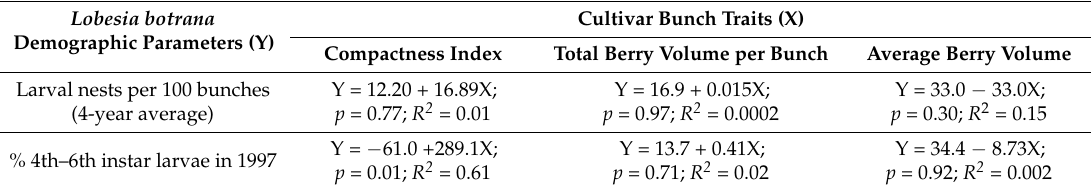
Table 3. Linear regression between cultivar bunch traits and Lobesia botrana demographic parameters. Lobesia botrana Demographic Parameters